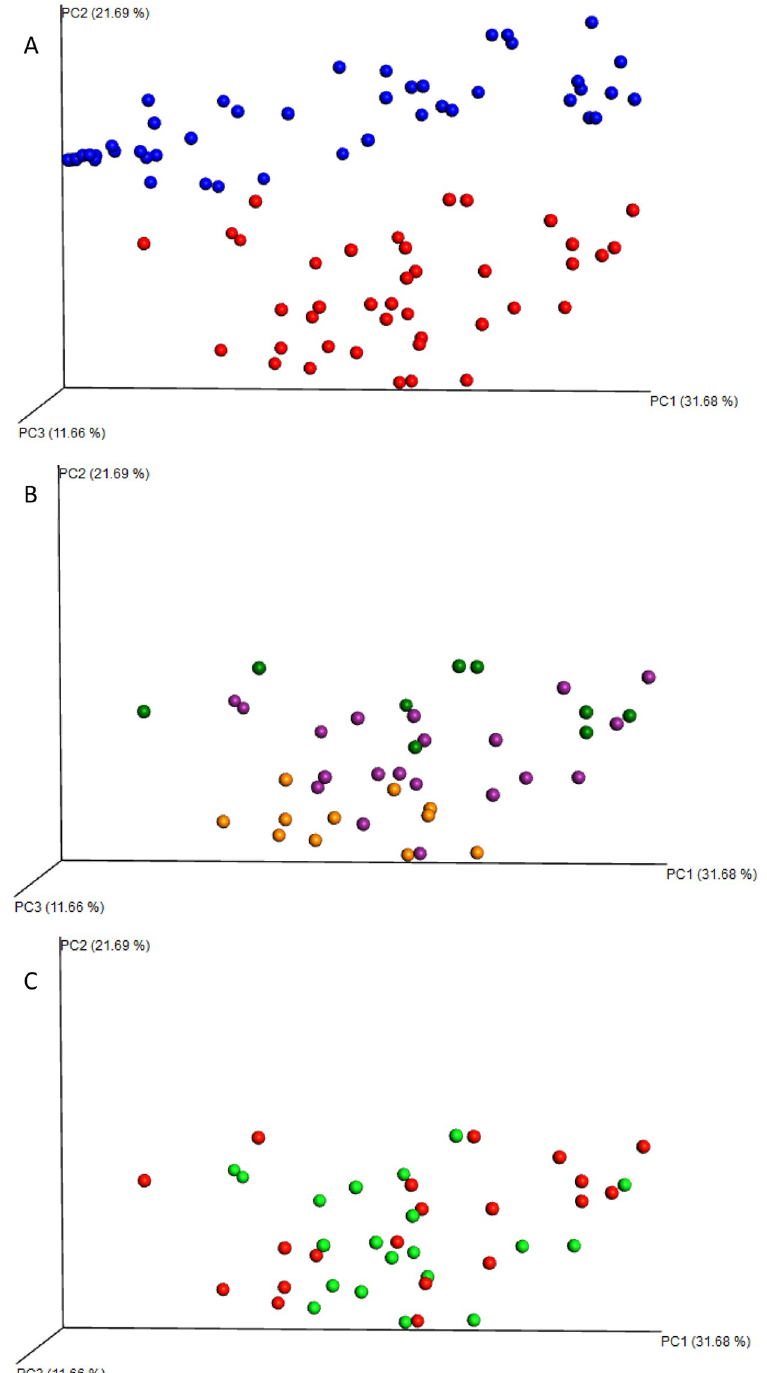
Fig 2. Weighted unifrac plots differentiating samples by A) tick species, B) life stage site (only A . americanum data shown; males in green, nymphs in purple, and females in orange), and C) sampling site (only A . americanum data shown; red represents site CSF and green represents site UR). The entire dataset is found in S1 Dataset and can be downloaded and manipulated to highlight subsets of data related to any variable in the metadata file.